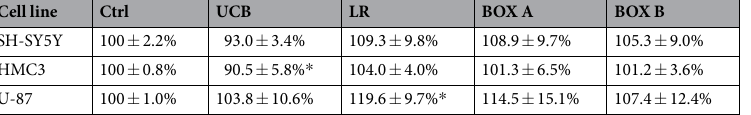
Table 2. Viability of human CNS cell lines exposed to UCB, LR, BOX A and BOX B for 4 h. Cell viability was evaluated by MTT assay. Concentration of tested compounds = 25 μ mol/L. Ctrl, control; UCB, unconjugated